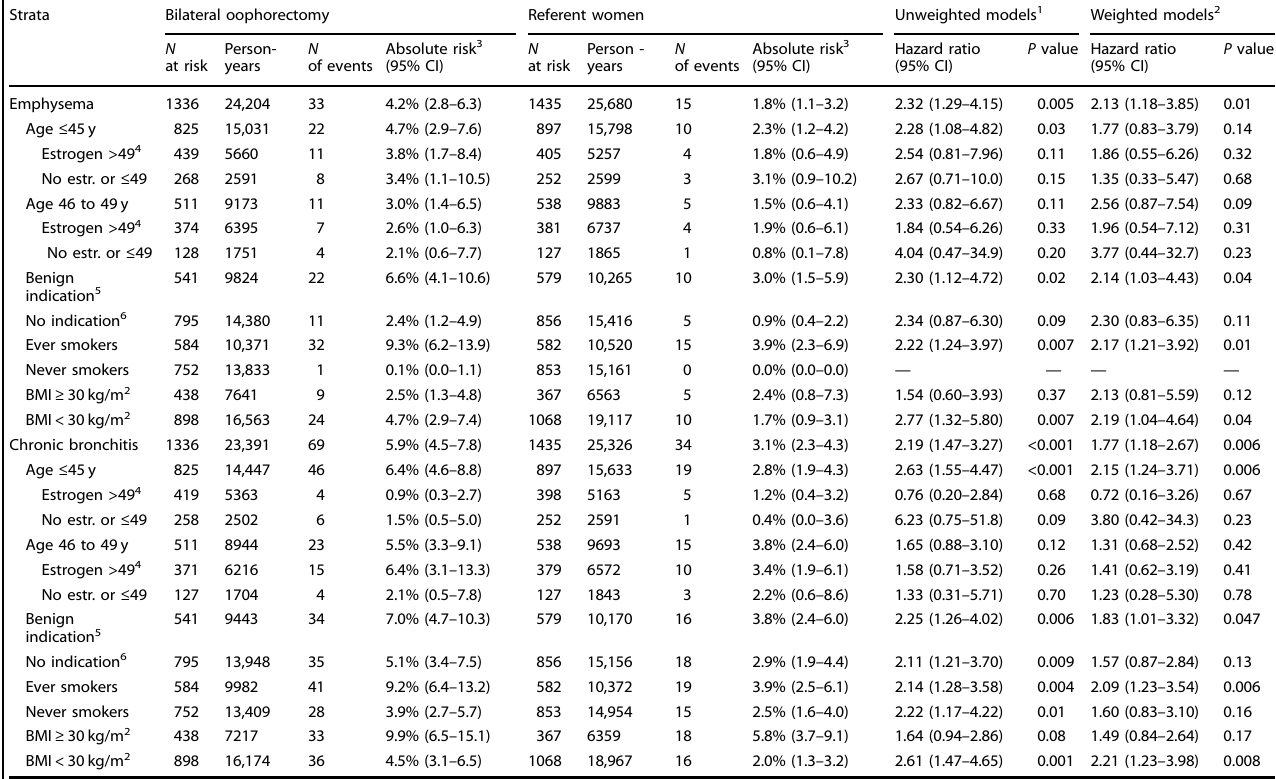
Table 4. Cumulative incidence of emphysema and chronic bronchitis overall and in strata by age at oophorectomy, estrogen therapy, surgical indication, cigarette smoking, and body mass